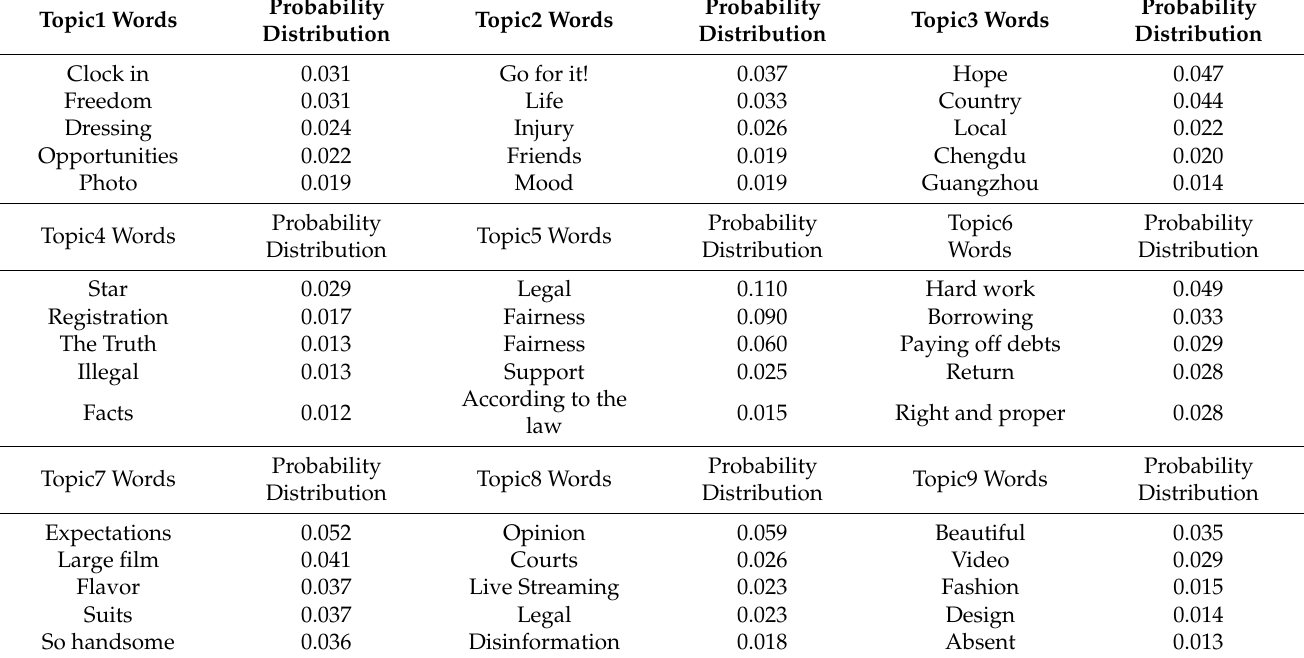
Table 13. B1 LDA theme model results.